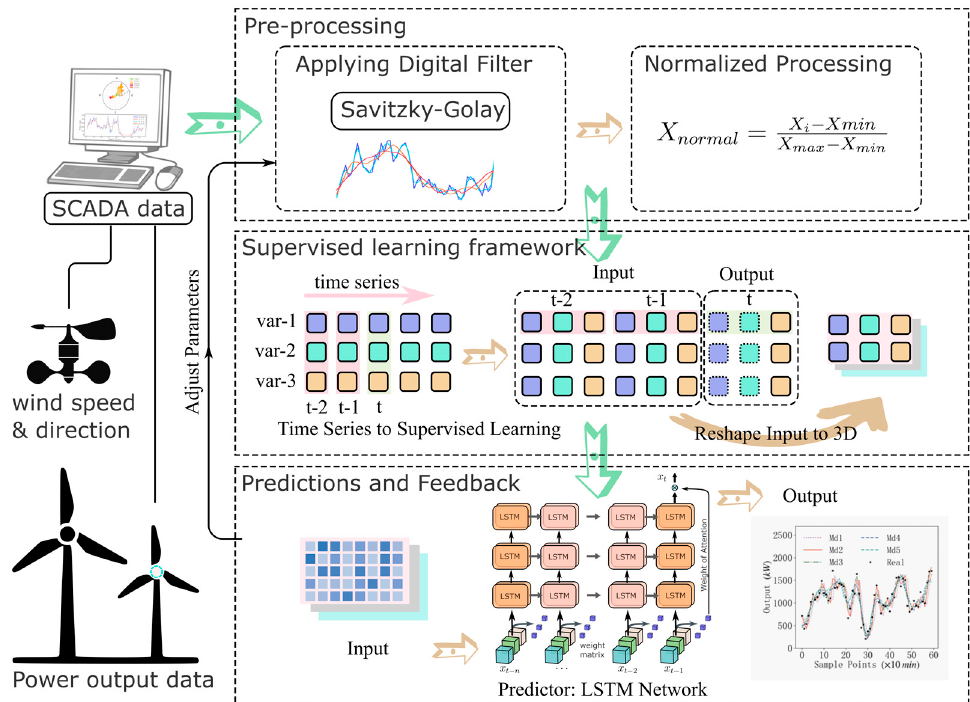
Figure 1. Data flow diagram of wind power short ‐ term forecasting task framework.